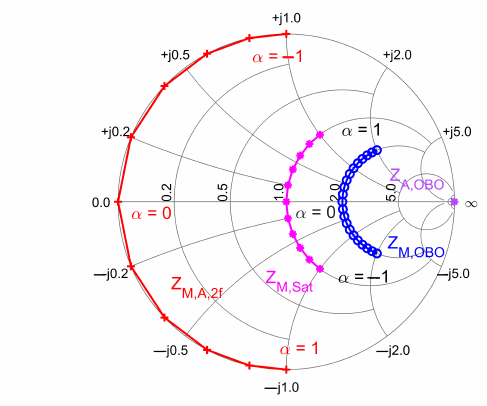
Figure 2. Intrinsic main and auxiliary impedances of the DPA class-J at the fundamental and second harmonics when R opt = 50 Ω .